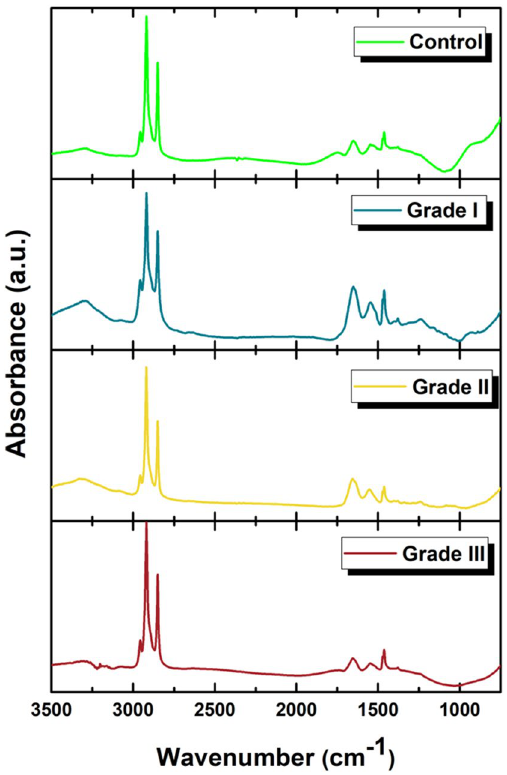
Figure 6. Stack graphs of characteristic FTIR spectra of breast tissue sections. Serial sections from those analyzed by THG microscopy in benign and grades I, II and III biopsies were used for the acquisition of FTIR spectra.